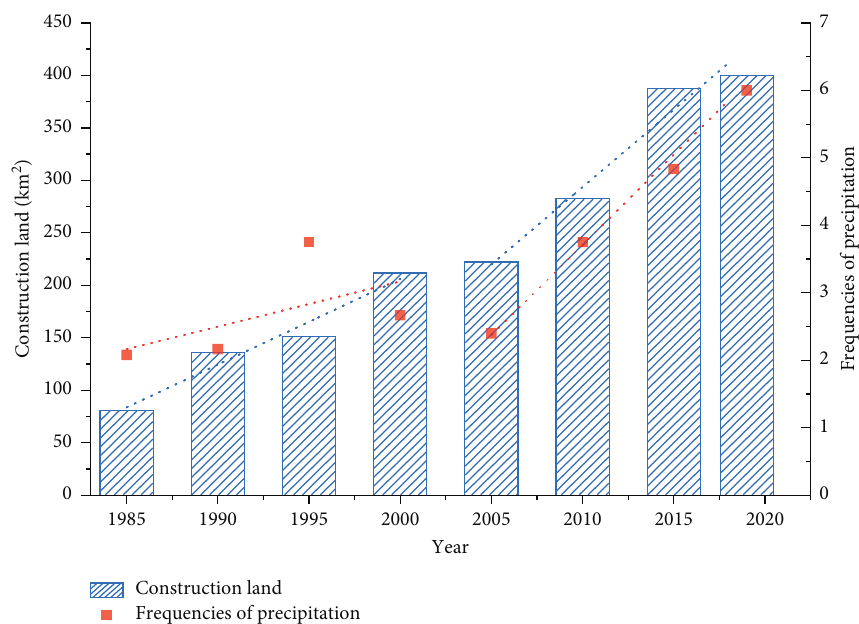
Figure 14: Construction land and frequencies of precipitation trend in the study area.